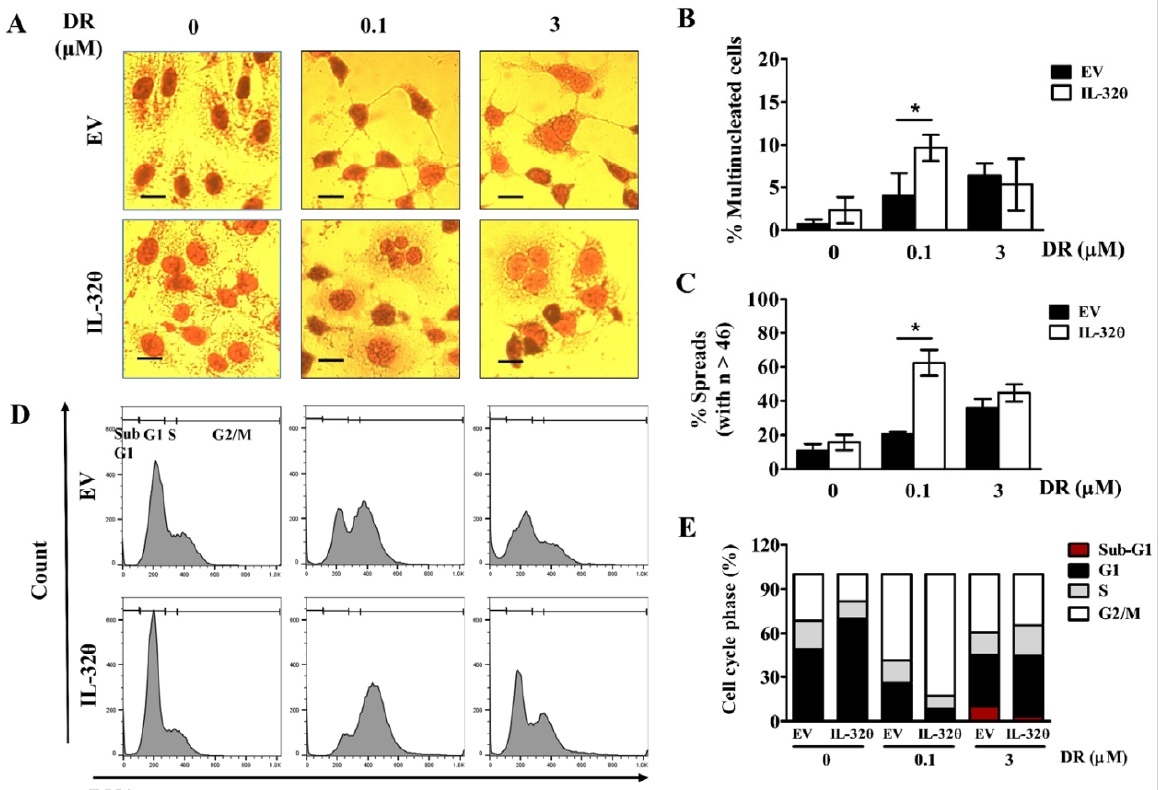
Figure 6. Effects of IL-32 θ on morphology, genome stability, and cell cycle progression in cells incubated with doxorubicin (DR). ( A ) Morphology of cells stained with hematoxylin and eosin. Scale bar, 10 µ m. ( B ) Cells with more than one nucleus are counted as multinucleated. ( C ) Ratios (%) of metaphase spreads with >46 chromosomes. Scale bar, 20 µ m. ( D , E ) Cell cycle phases determined by PI staining and flow cytometry. * p < 0.05 (Student t -tests). Results are representative of three independent